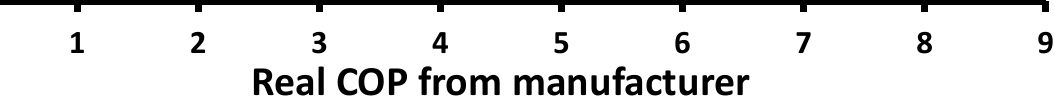
Figure 4. Comparison of the calculated COP with the developed model of the COP by Bitzer.